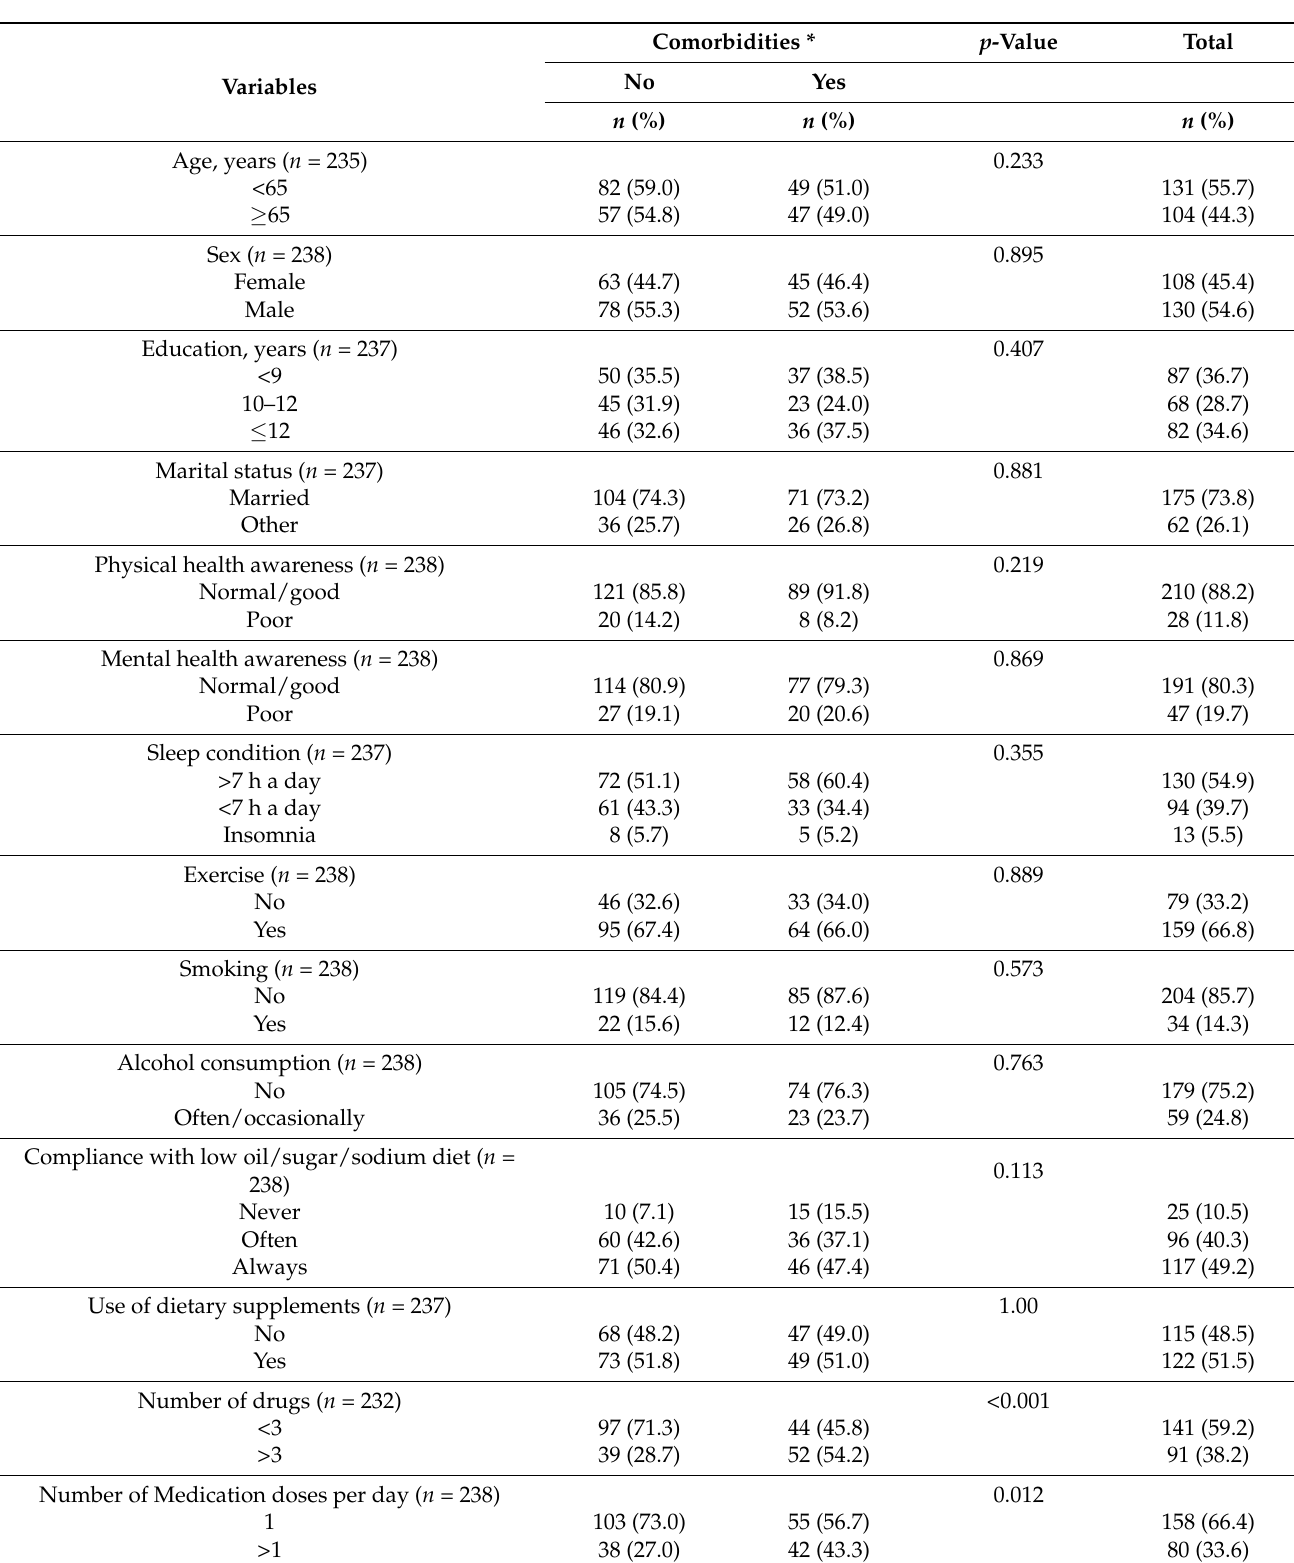
Table 1. Baseline characteristics and behaviors of nonadherence in the total cohort and in patients with or without comorbidities